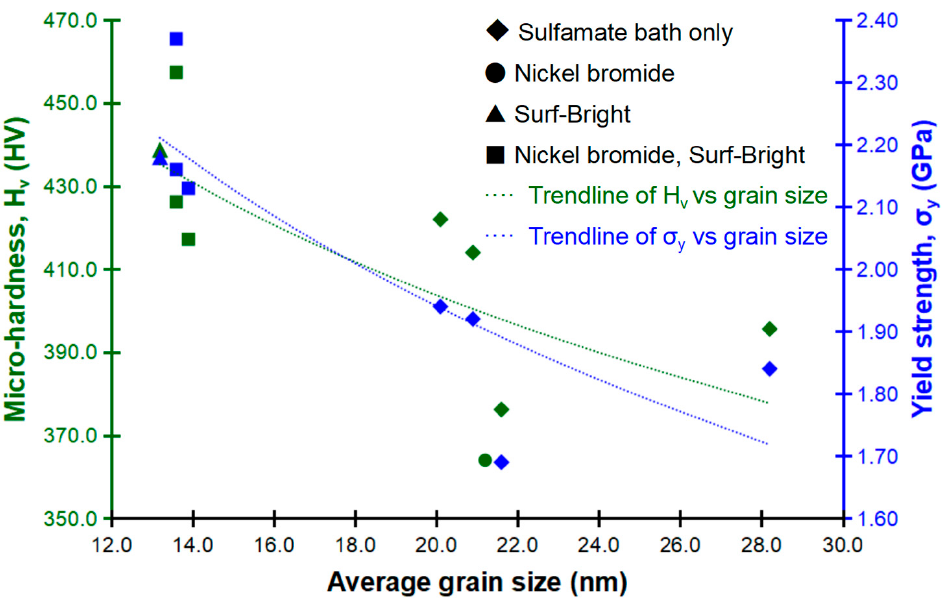
Figure 7. Relationships between the average grain size, micro-hardness and yield strength.